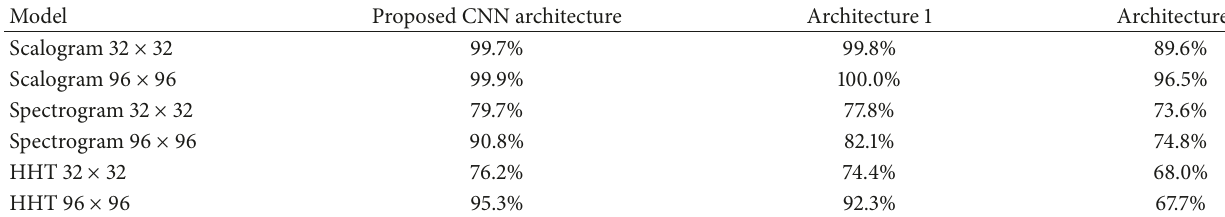
Table 11: Sensitivity for MFPT data set.